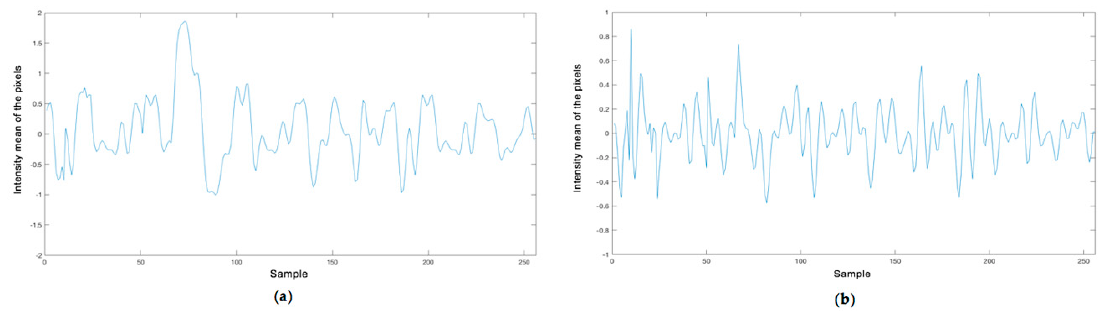
Figure 5. Comparison of the signals: ( a ) signal with a passband filter of 0.5 Hz to 3.1 Hz applied; ( b ) signal processed with the derivative module of our application.